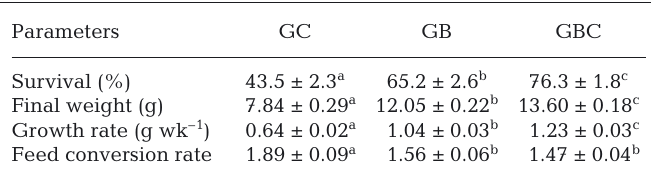
Table 2. Production performance (mean ± SD, n = 4) of Litopenaeus vannamei over the 56 d experimental period. See Table 1 for treat-